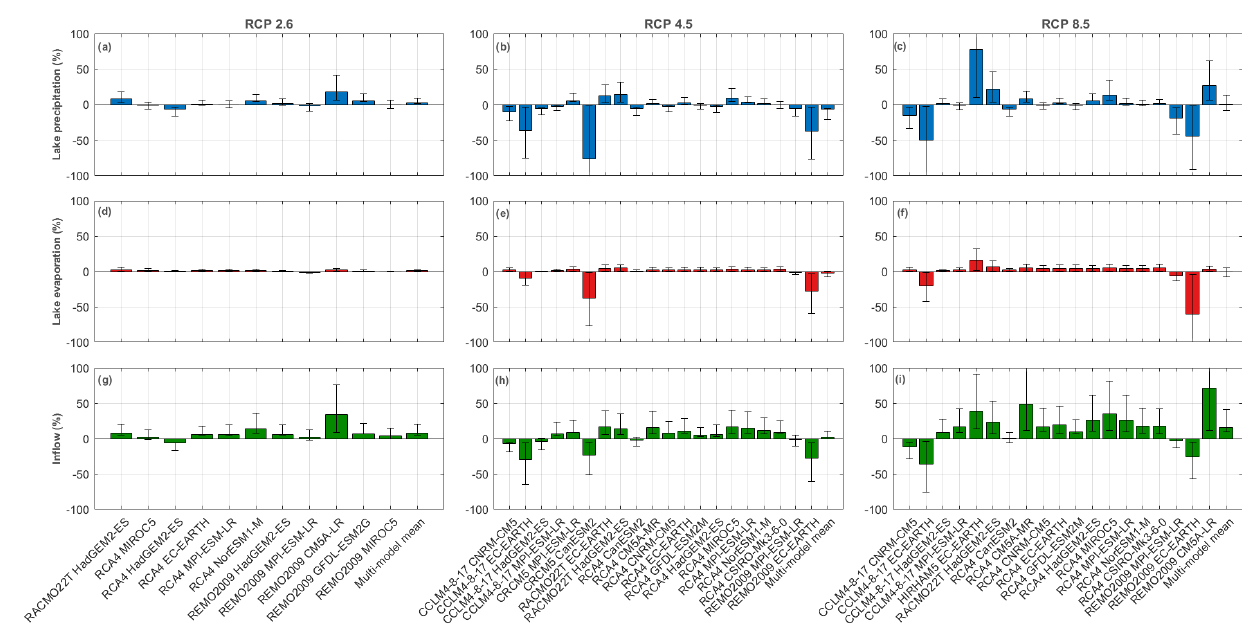
Figure E3. As in Fig. 7, but bias corrected using empirical